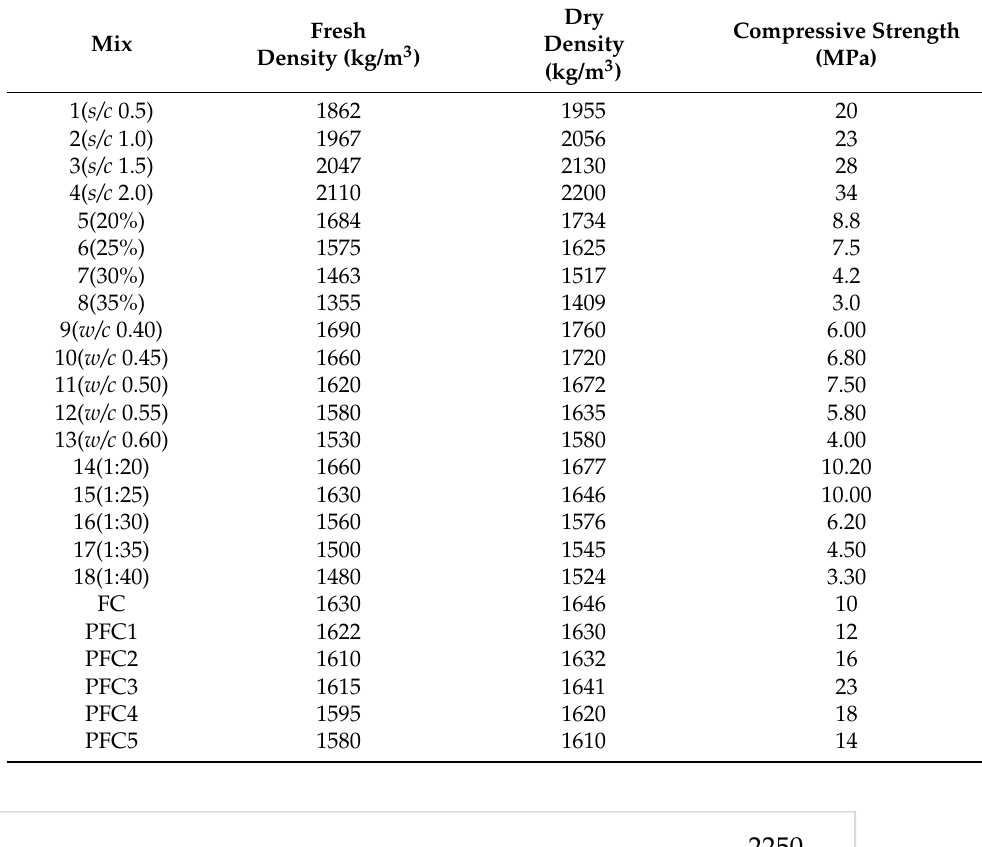
Table 4. Densities and compressive strength of mortar and foamed concrete.